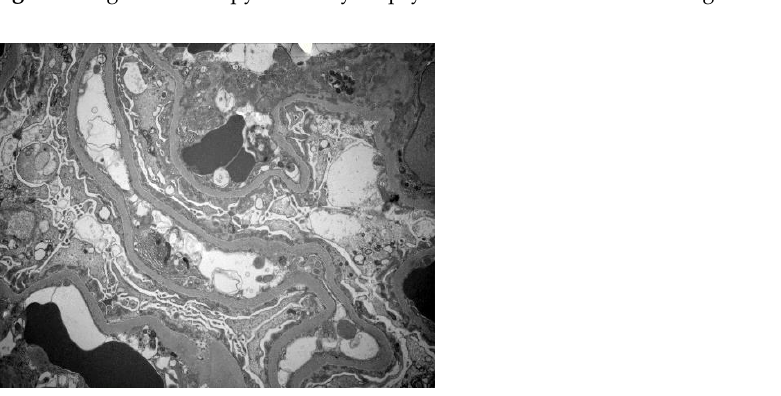
Figure 2. Electron microscopy demonstrates diffuse, almost complete podocyte foot processes effacement without immune mesangial or capillary wall deposits (Direct magnification 20,000 ×).